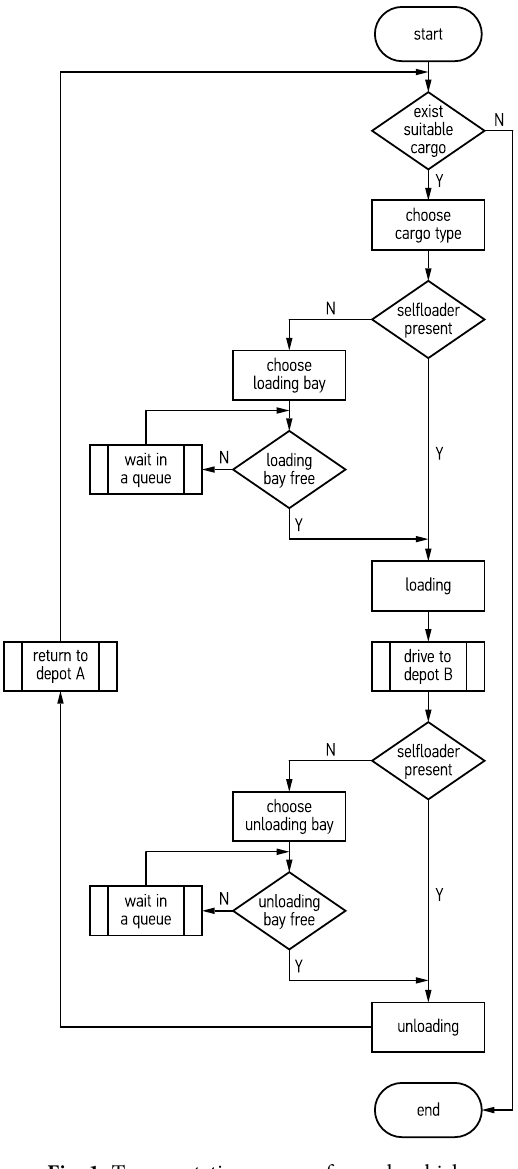
Fig. 1. Transportation process for each